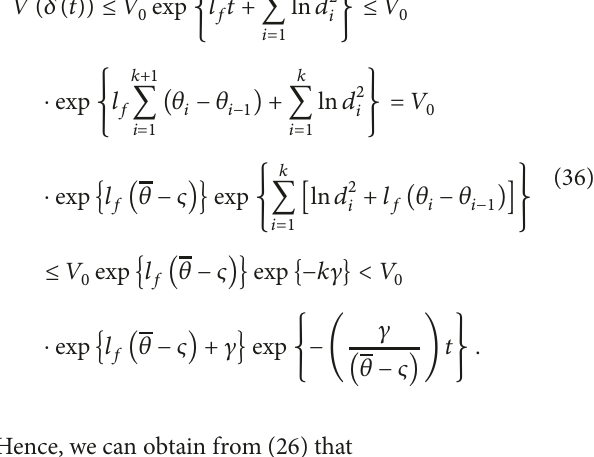
topology represented by Figure 2. And the Laplacian and